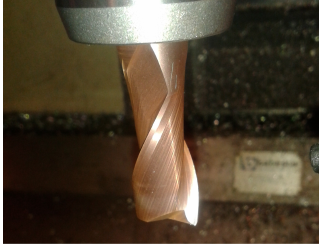
Figure 8. The tool used for the force measurements.